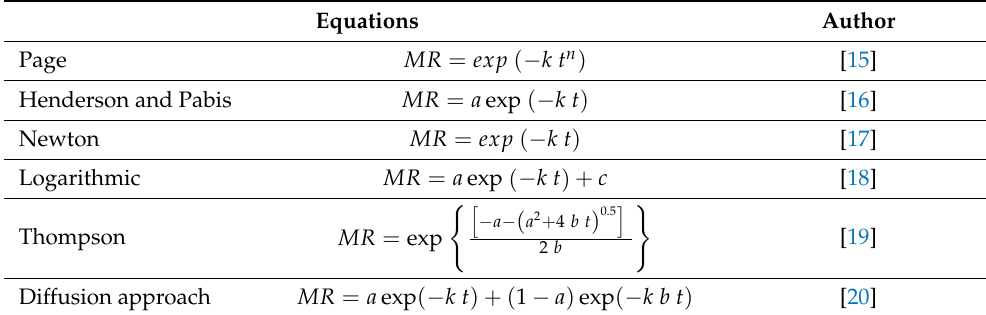
Table 1. Mathematical equations used for drying